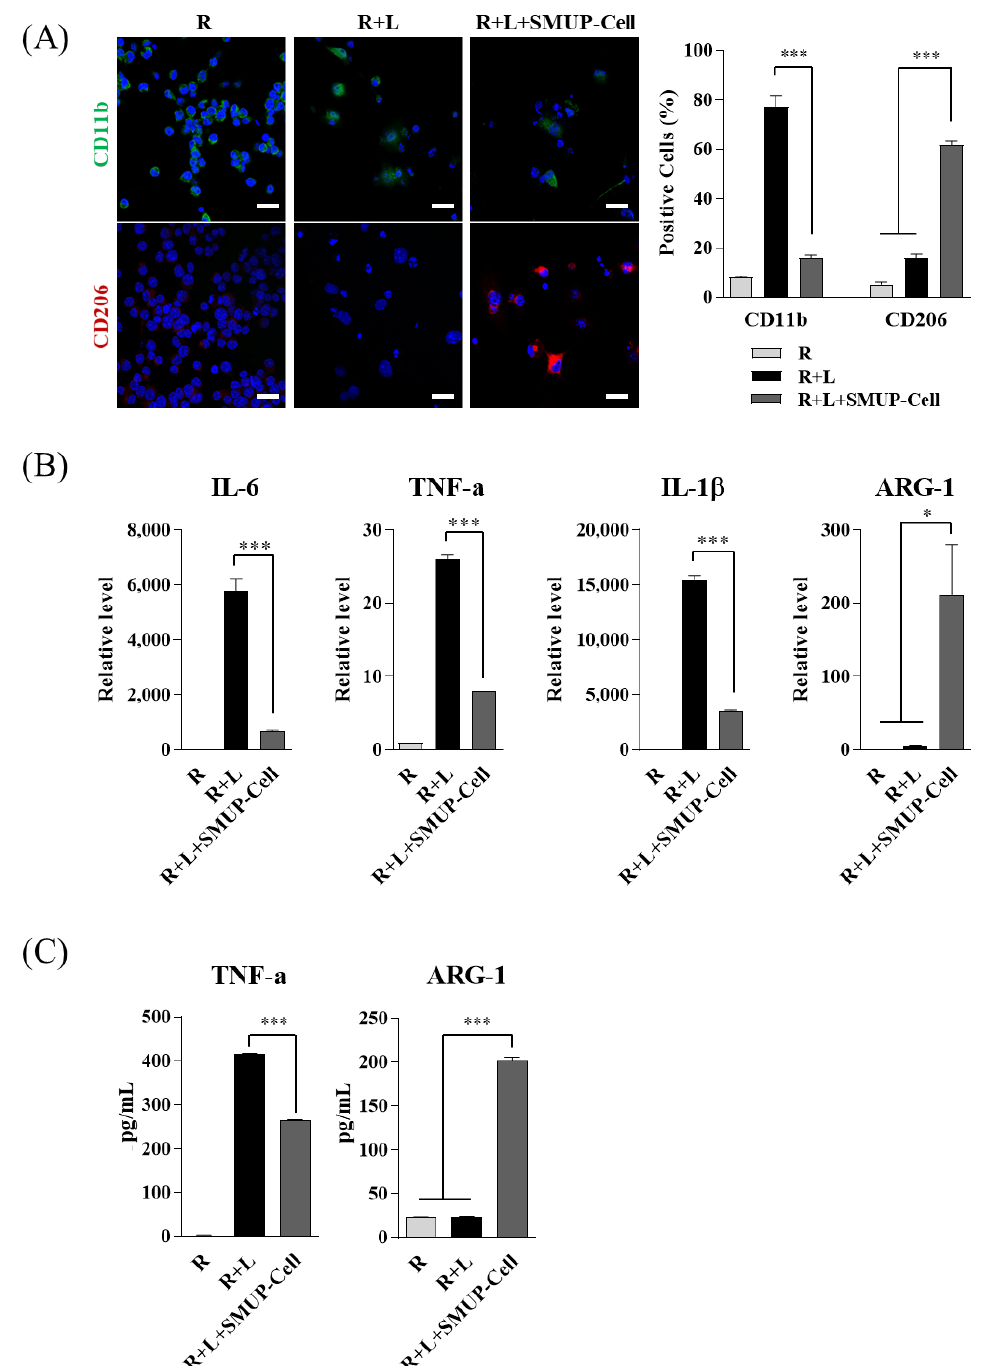
Figure 3. Macrophage polarization by SMUP-Cells under LPS-stimulated inflammation conditions. Mouse macrophages (Raw 264.7) were exposed to LPS and co-cultured with SMUP-Cells for 2 days. ( A ) The M1 and M2 phenotypes were evaluated by staining CD11b (green) and CD206 (red), respectively, followed by confocal microscopy. Nuclei were stained with Hoechst 33342 (blue). Quantitative data represent the percentage of CD11b + or CD206 + cells. Scale bar = 100 µm. Confocal microscopy of co-cultured macrophages showed a significant decrease in the M1 marker CD11b and an increase in the M2 marker CD206. ( B ) Quantification of gene expression levels of inflammatory cytokines (mouse IL-1b, IL-6, and TNF- α ) and anti-inflammatory cytokines (mouse ARG-1) was determined by qRT-PCR. Levels were normalized to those of β -actin, with expression levels in naïve cells set at 1. ( C ) Secretion of TNF- α and ARG-1 was evaluated by ELISA. Medium from SMUP-Cell co-cultures showed significantly decreased levels of TNF- α and elevated levels of ARG-1. ( A – C ) Data represent mean ± SD (n = 3 per group). * p < 0.05, *** p < 0.001. R, Raw 264.7 cells; L, LPS treatment.